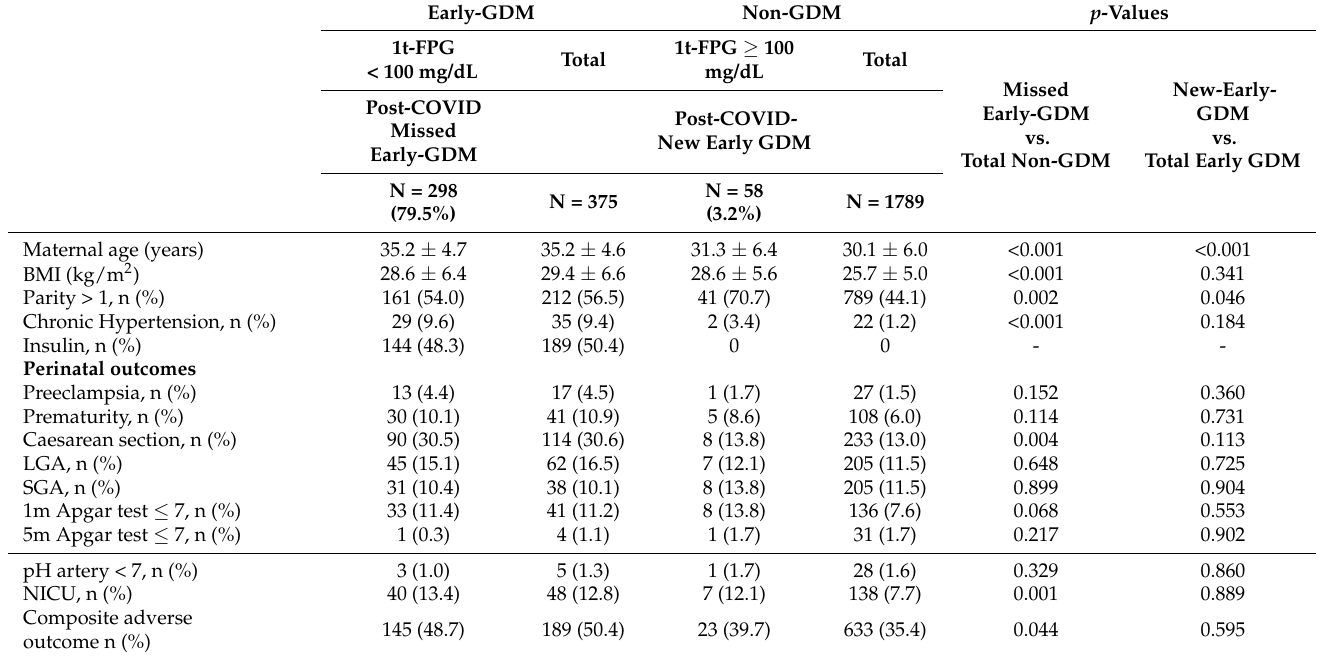
Results are shown as frequency (%) or means ± SD. BMI: body mass index; GWG: gestational weight gain; LGA: large for gestational age; SGA: small for gestational age; NICU: neonatal intensive care unit admission; vs.: versus. Composite adverse outcome: preeclampsia, caesarean, LGA, Apgar < 7 at 1st or 5th min, and/or NICU admission. p -values adjusted for maternal characteristics (maternal age, BMI, parity and chronic